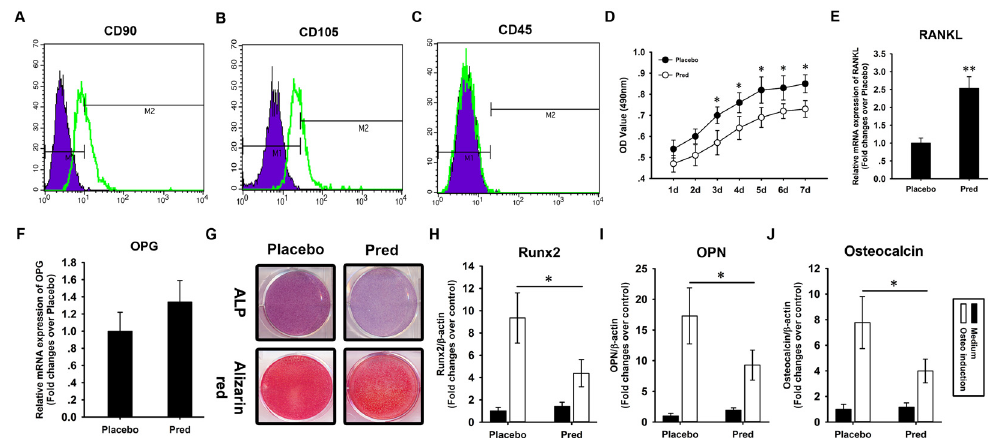
Fig 2. BMSC osteogenesis is defective in the vertebral body of the osteoporotic mouse. BMSCs were isolated from the vertebral bodies of mice treated with the placebo or prednisolone pellets, cultured in vitro , and analyzed by flow cytometry to detect the expression of the mesenchymal surface markers CD90 (A) and CD105 (B) and the hematopoietic surface marker CD45 (C) . MTT assay was used to analyze the proliferation of BMSCs from prednisolone and placebo group (D) . RANKL (E) and OPG (F) mRNA expression were analyzed using quantitative RT-PCR. The BMSCs were then induced to undergo osteogenesis. Alkaline phosphatase (ALP) and Alizarin Red staining were performed at weeks 1 and 3, respectively (G) . At week 2, total RNA was extracted and subjected to quantitative RT-PCR analysis using primers for Runx2 (H) , OPN (I), and OC (J) . β -actin was used